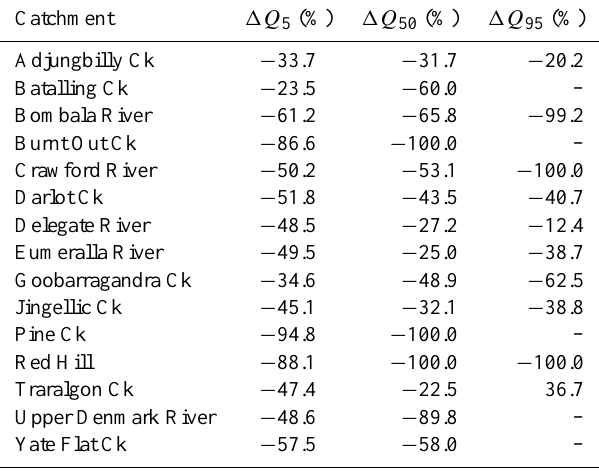
Table 2. Relative changes in High ( Q 5 ), Median ( Q 50 ), and Low flow ( Q 95 ) between pre-treatment and post-treatment periods.